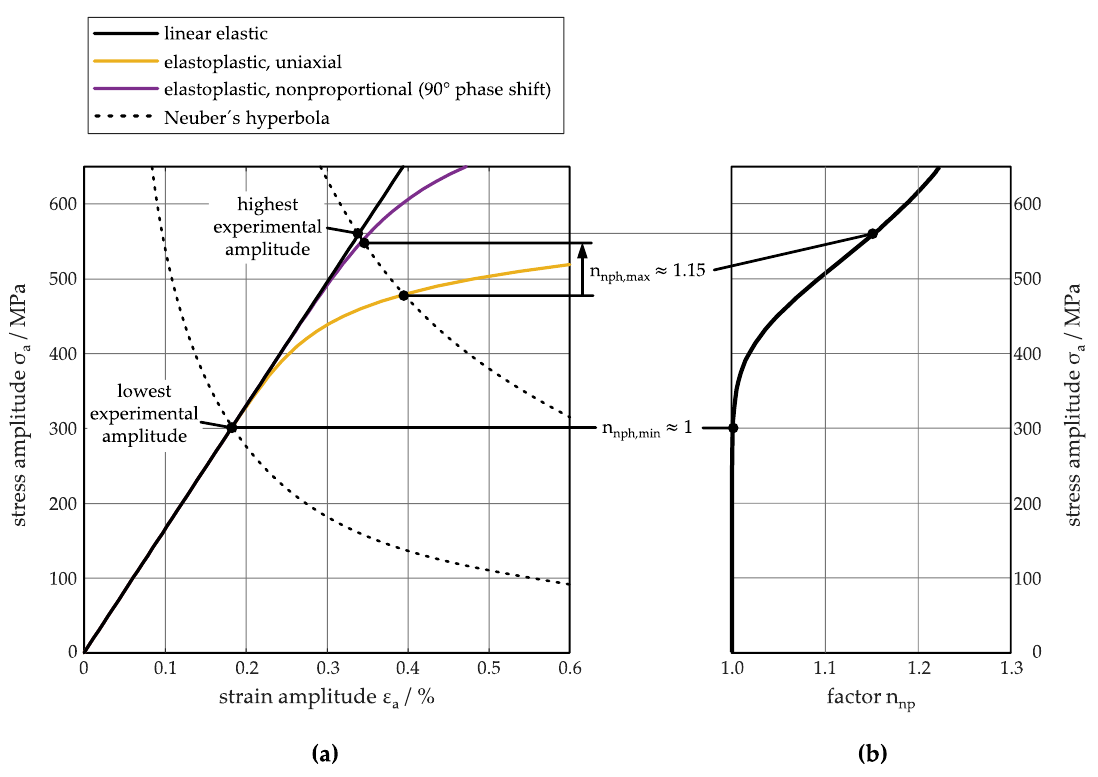
Figure 16. Determination of load–height-dependent correction factor n np for nonproportional hard- ening: ( a ) calculation of correction factor through notch root approximations according to Neuber and ( b ) values for n np for linear elastic stress amplitudes.